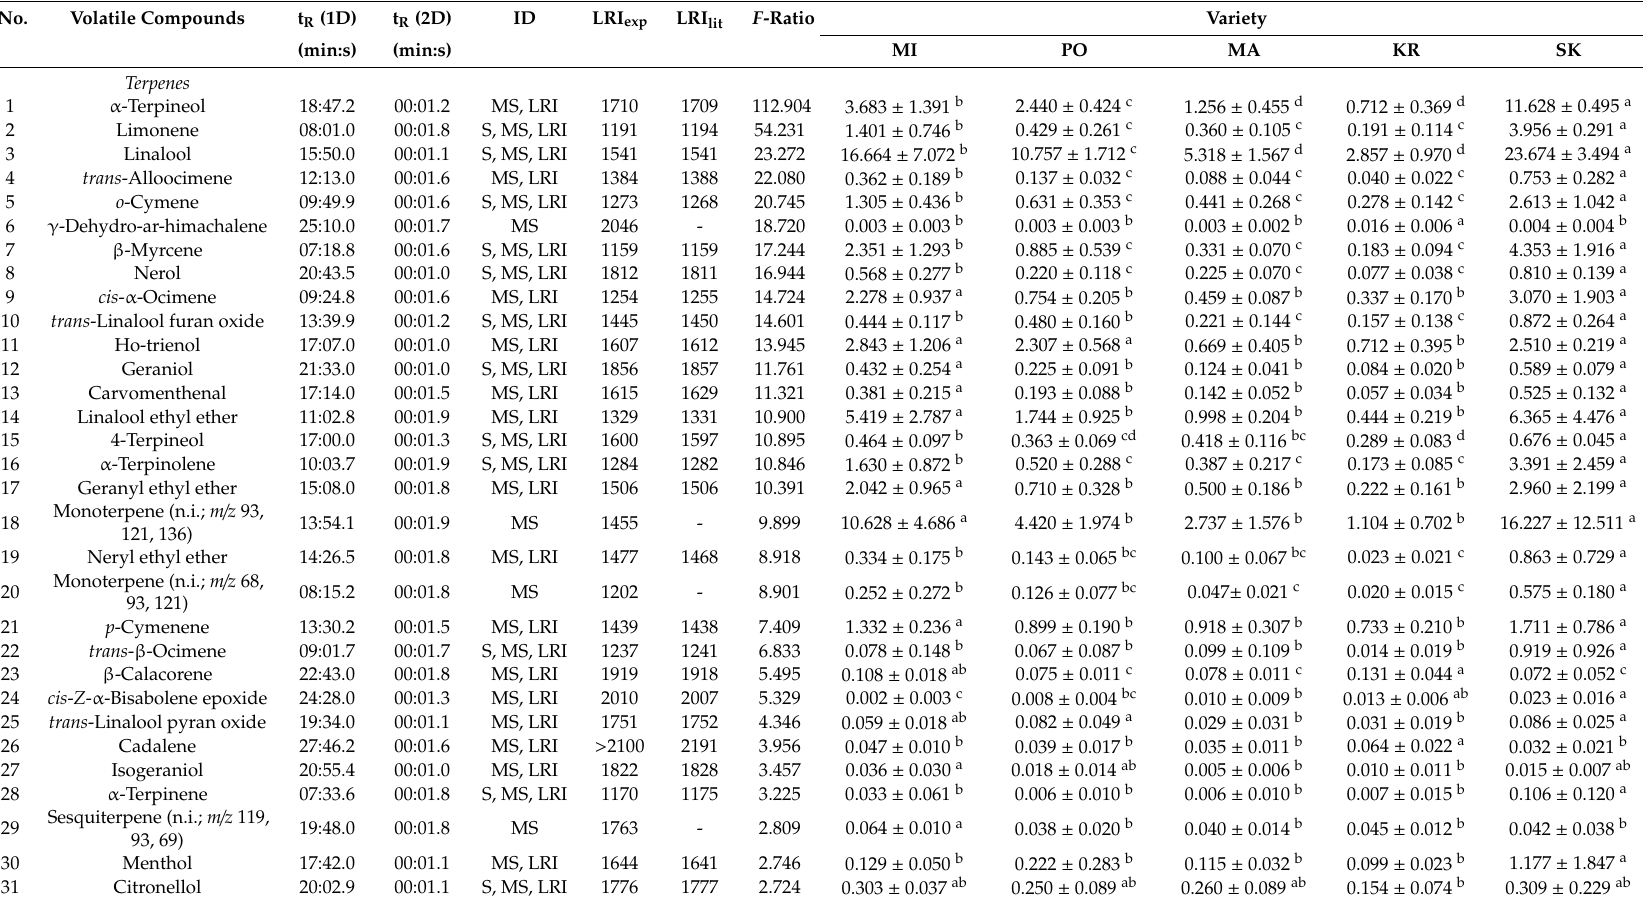
Table 2. Concentrations ( µ g / L relative to internal standard 2-octanol) of volatile aroma compounds found in Croatian monovarietal wines obtained by headspace solid-phase microextraction followed by comprehensive two-dimensional gas chromatography-mass spectrometry with time-of-flight mass spectrometric detection (HS-SPME / GC × GC-TOF-MS) sorted by compound class and descending Fisher F